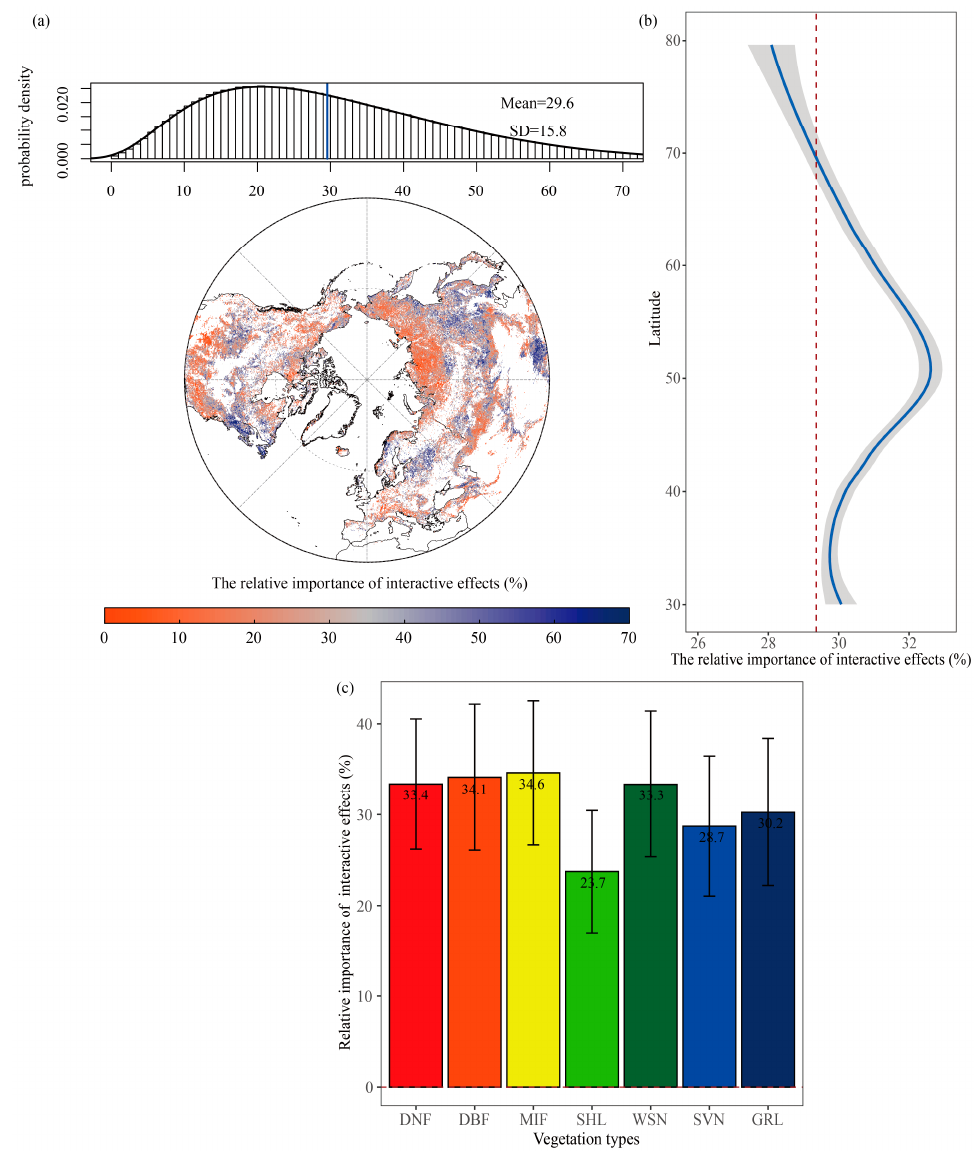
Figure 2. ( a ) The spatial distribution of the relative importance of interactive effects ( RI IAE ) on the RVG reg trends over the northern extratropics. RI IAE ( b ) along the latitudinal gradient and ( c ) across different biomes including deciduous needleleaf forests (DNF), deciduous broadleaf forests (DBF), mixed forests (MIF), shrublands (SHL), woody savannas (WSN), savannas (SVN), and grasslands (GRL).